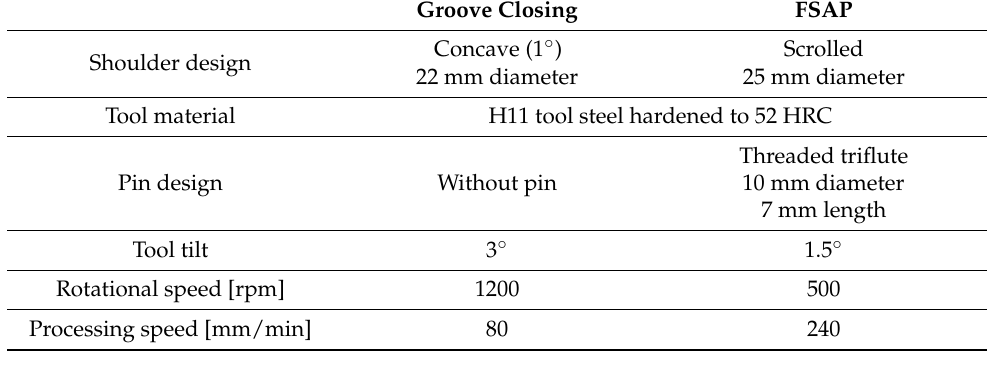
Table 3. Tool features and key parameters used for FSAP. (Tools provided by Stirtec GmbH, Premstätten, Austria).